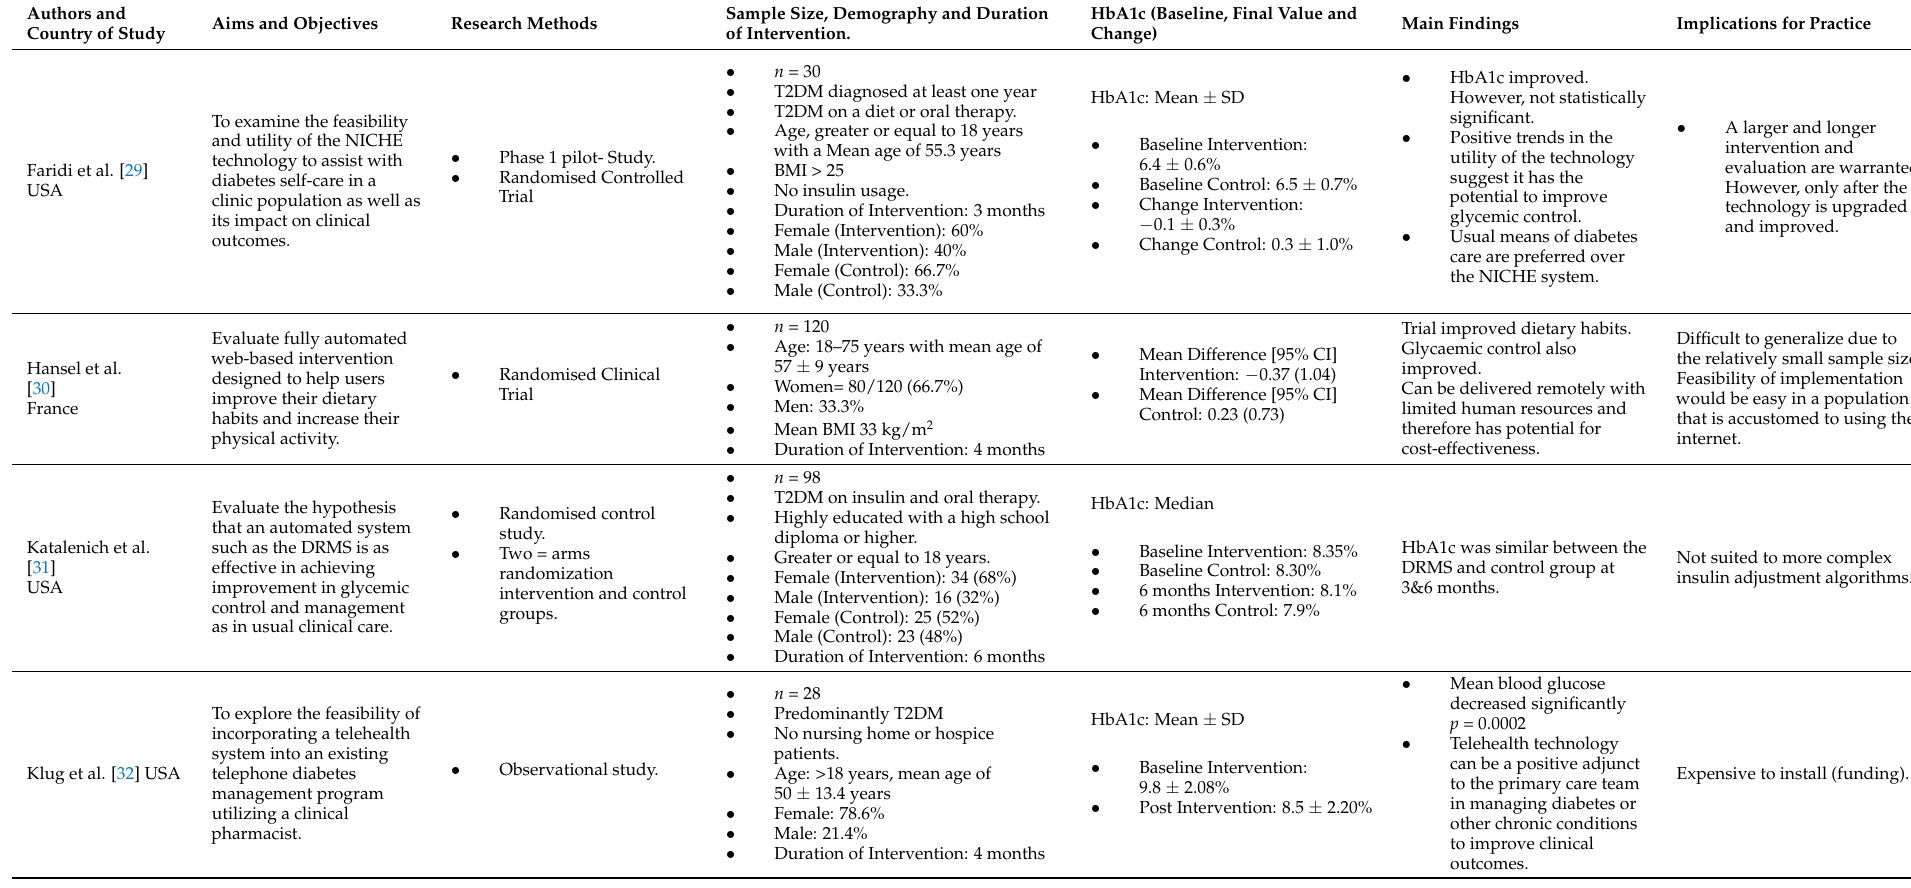
Table 2. Characteristics of studies included in the